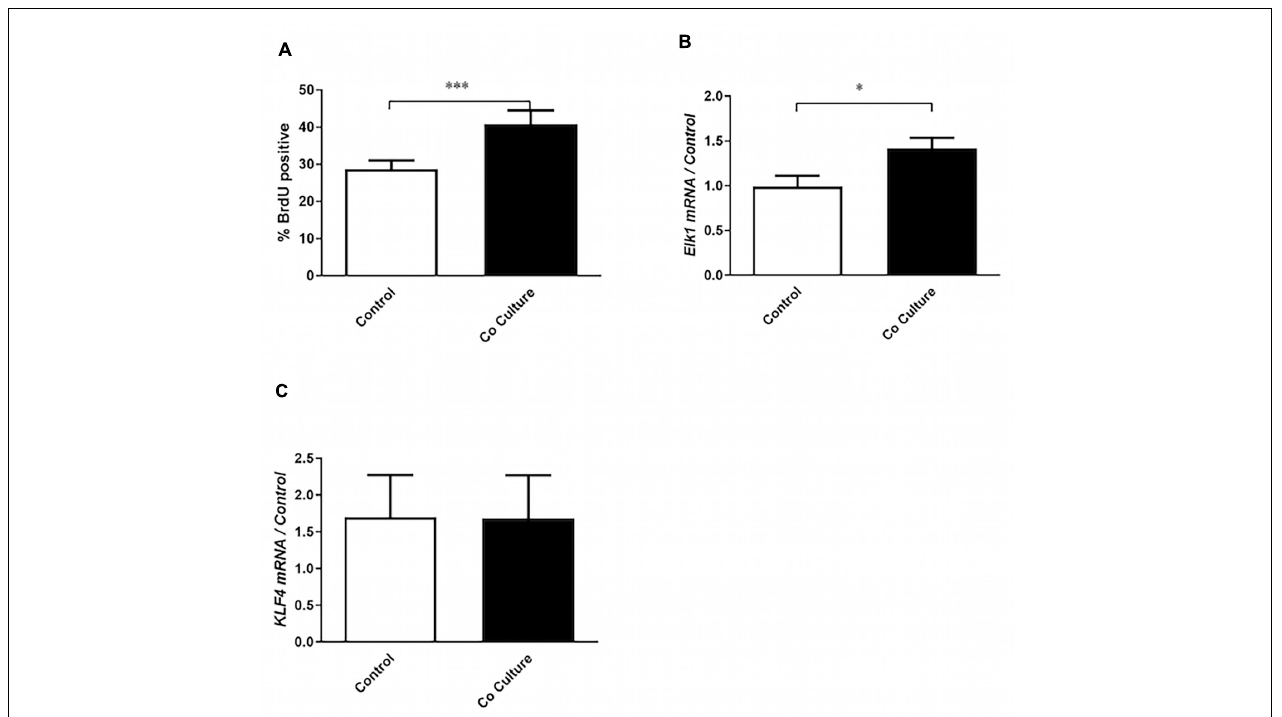
FIGURE 1 | Co-culture with epithelial cells induces the proliferative phenotype in airway smooth muscle cells. (A) Airway smooth muscle cells (ASMCs) were cultured with (co-culture) or without (control) BEAS-2B cells for 24 h. Six hours after the initiation of co-culture, cells were pulsed with bromodeoxyuridine (BrdU). BrdU incorporation by flow cytometry was then performed to mark ASMCs that had entered into S-phase ( n = 19). (B,C) RT-qPCR was performed on ASMCs to assess the expression of Elk1 ( n = 7) and KLF4 ( n = 6) after 24 h of co-culture with BEAS-2B cells, or without co-culture (control). Data are representative of means + 1 SE. Student’s paired t -test was utilized to compare groups. “ n ” refers to number of individual airway smooth muscle donors analyzed. ∗ P < 0.05; ∗∗∗ P <